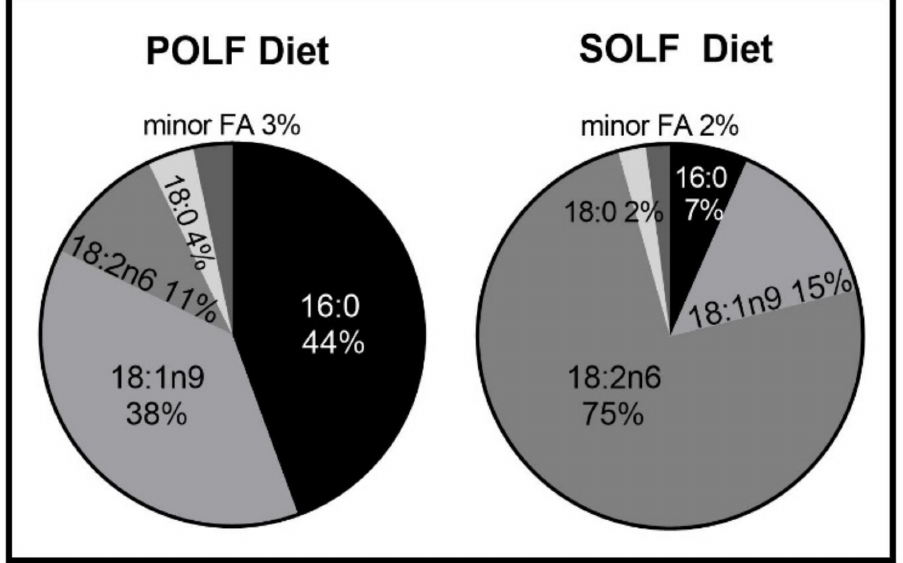
Figure 1. Dietary fatty acid composition of the oils used in the POLF and SOLF diets. Dietary oils ( n = 3 samples/group) were analyzed by gas chromatography, expressed as percent of total fatty acids. All samples have a coefficient of variation of <3% between experimental